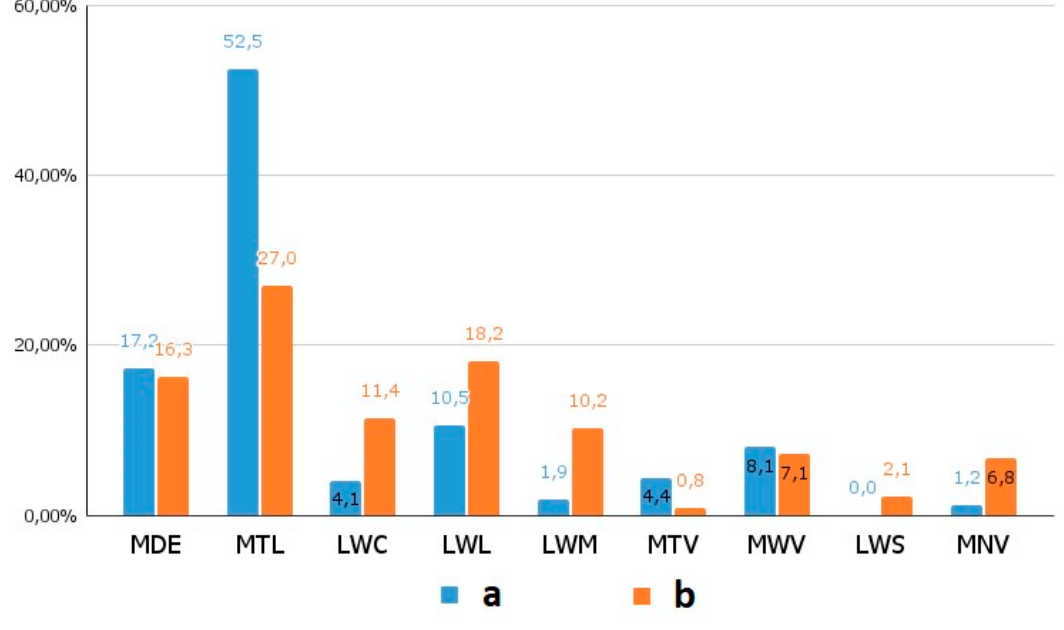
Figure 7. Comparison of the spatial structure of the permafrost landscapes: (a) Permafrost–Landscape Map of the Republic of Sakha (Yakutia) [17]; (b) result obtained by the permafrost landscape map of the Orulgan